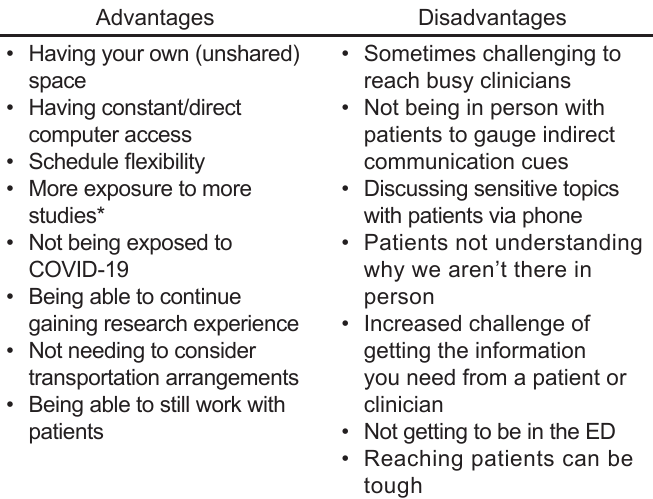
Table 2. Response themes of remote research associates’ self- reported advantages and disadvantages of conducting remote